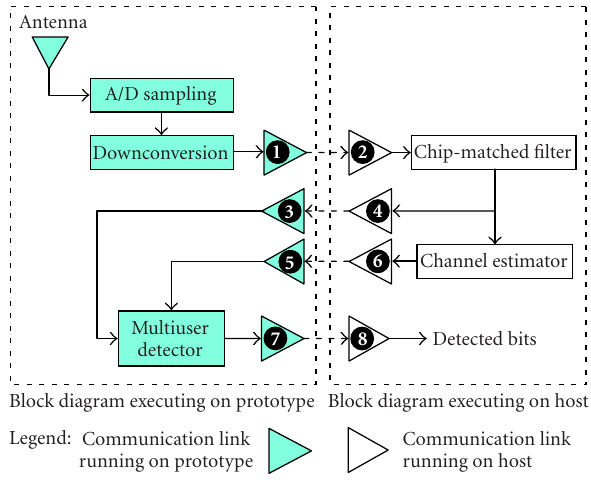
Figure 9: The block diagram from Figure 5, from which blocks not part of each partition have been removed and to which appropriate communication links have been inserted. Both the host and proto- type diagrams are